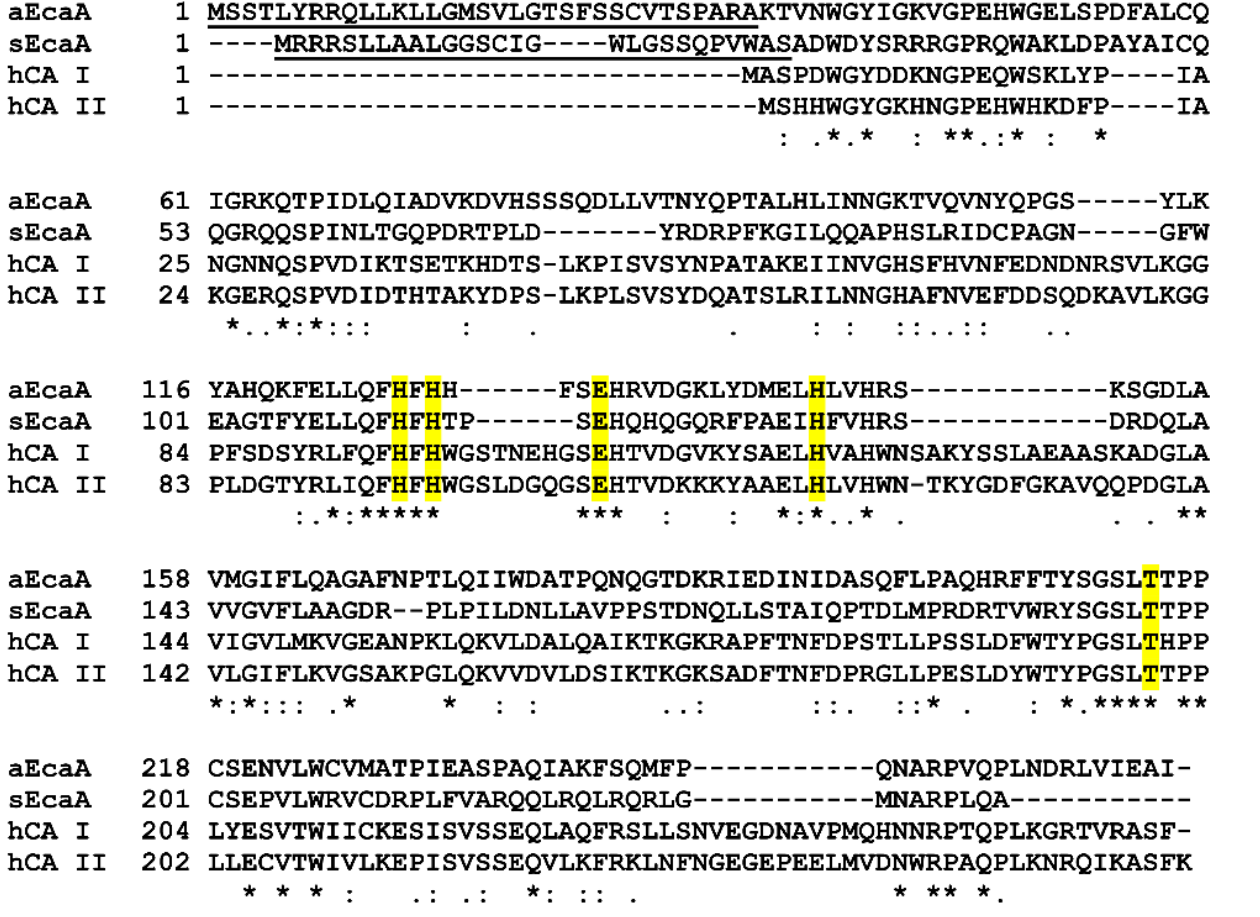
Figure 8. Multiple sequence alignment of Anabaena EcaA (aEcaA), Synechococcus EcaA (sEcaA), hCA I and hCA II. Conserved residues are indicated with an asterisk (*), while (:) and (.) indicate conservative and semi-conservative substitutions, respectively. Histidine residues involved in zinc coordination, Thr199 and Glu106 (hCA II numbering) are highlighted in yellow. Tat-signal peptides are underlined.